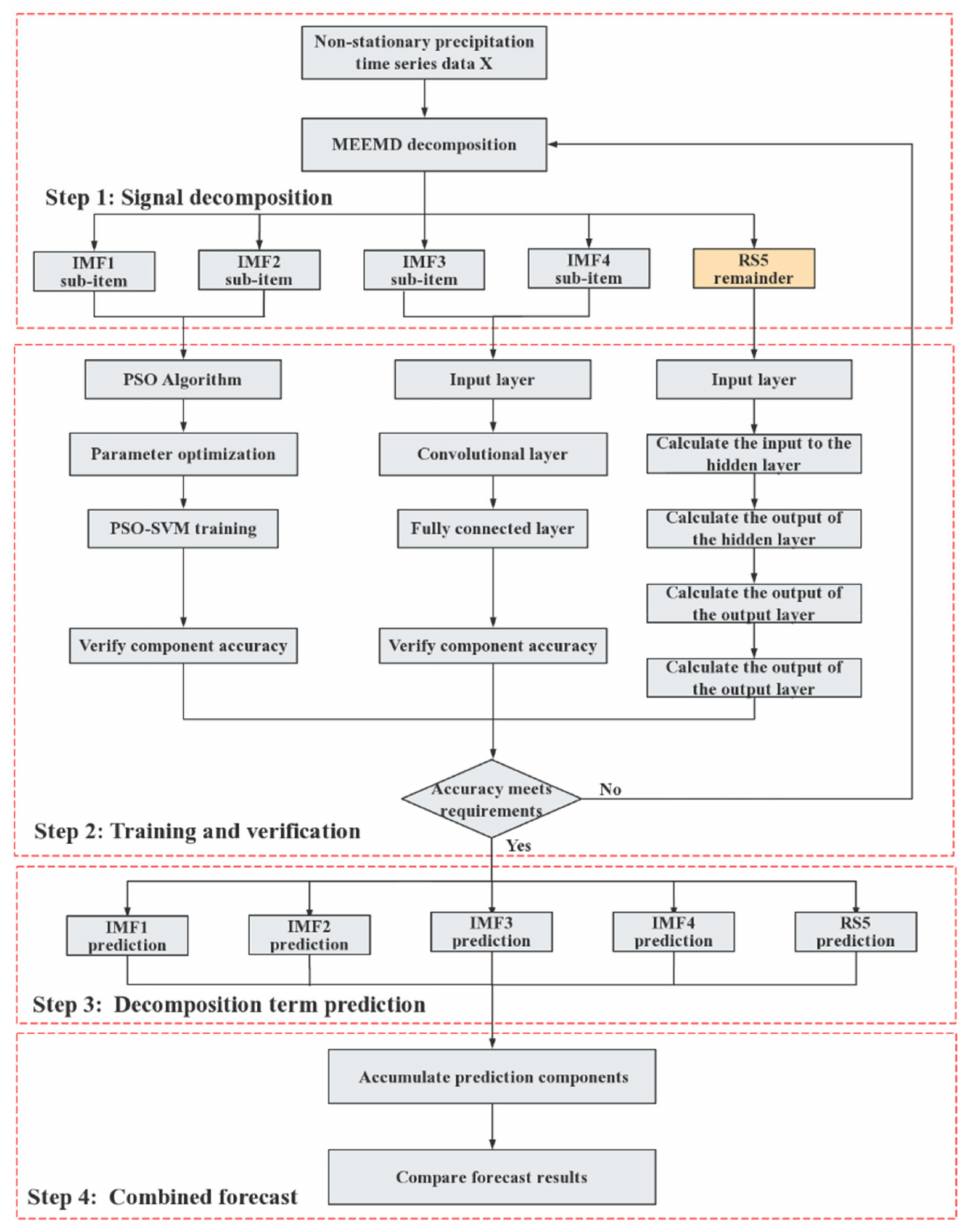
Figure 1. The MDPRM model